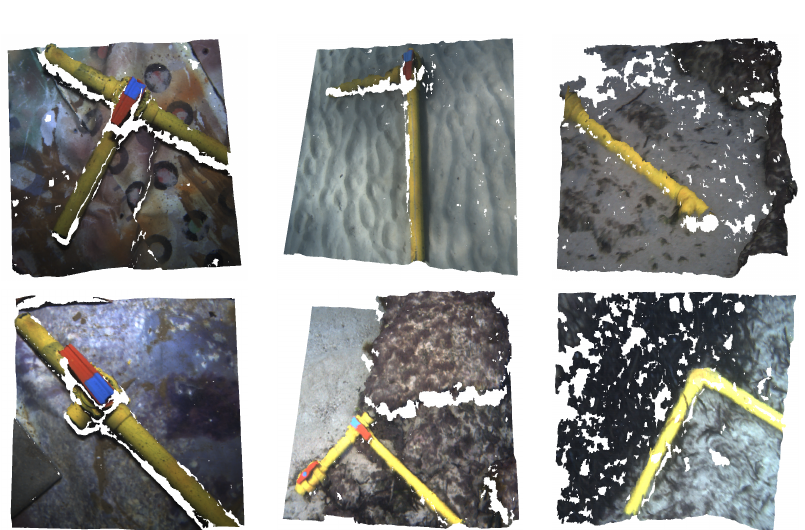
Figure 5. Point clouds from the dataset showcasing diverse pipe structures and valve connections over different